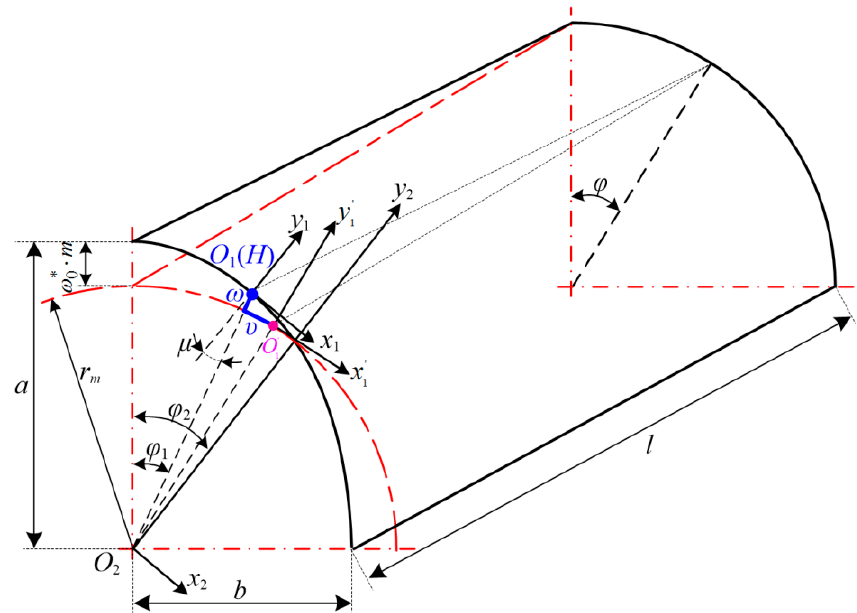
Figure 2. Deformation of the conventional flexible wheel with no load after assembly.